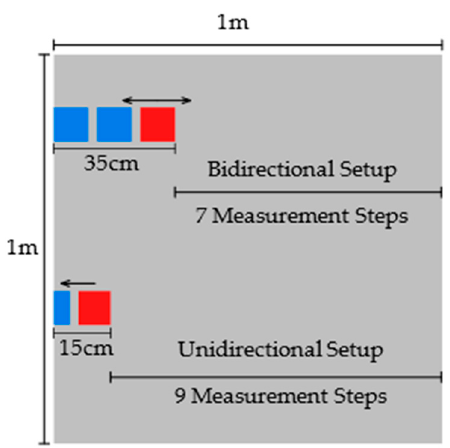
Figure 10. Ranging test setup and plate, the number of 10 cm steps for each transducer setup is illustrated, the bidirectional transducer setup is 35 cm in length and unidirectional transducer setup is 15 cm. Transmitters are represented by the red squares and receivers by the blue squares. The arrows indicate the directions of wave generation.